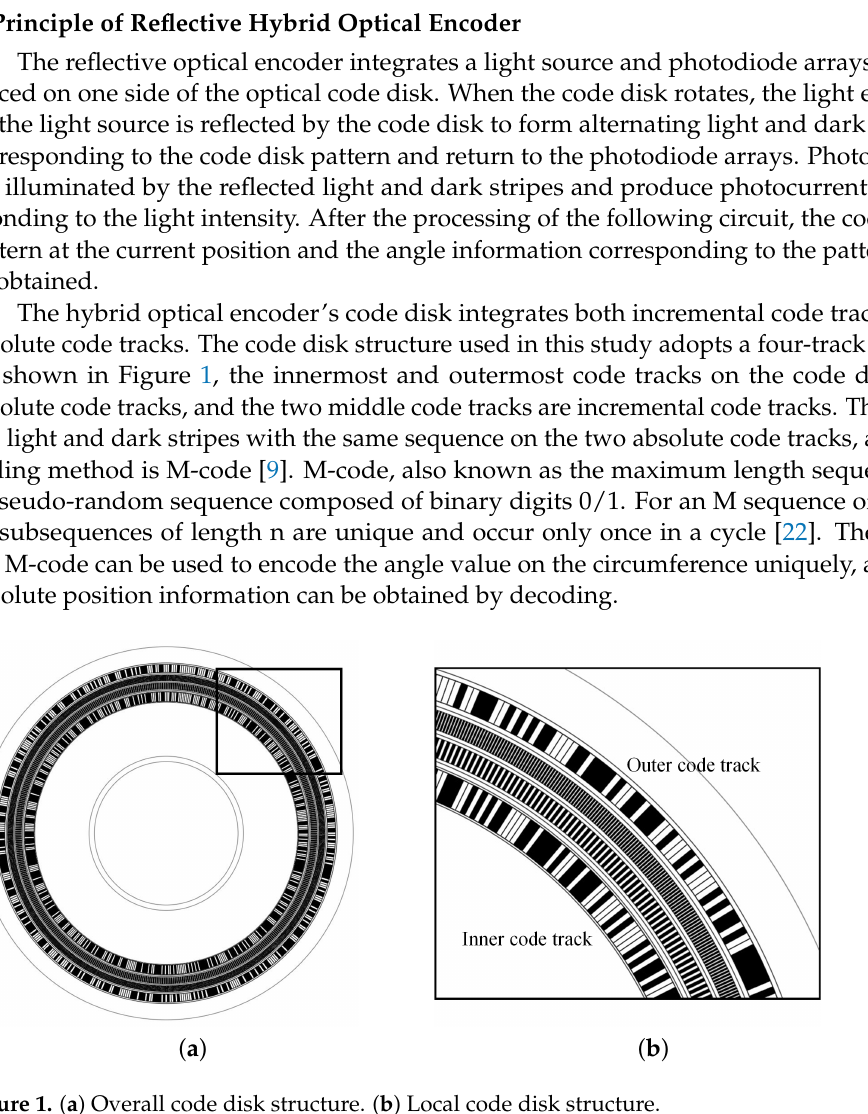
Figure 1. ( a ) Overall code disk structure. ( b ) Local code disk